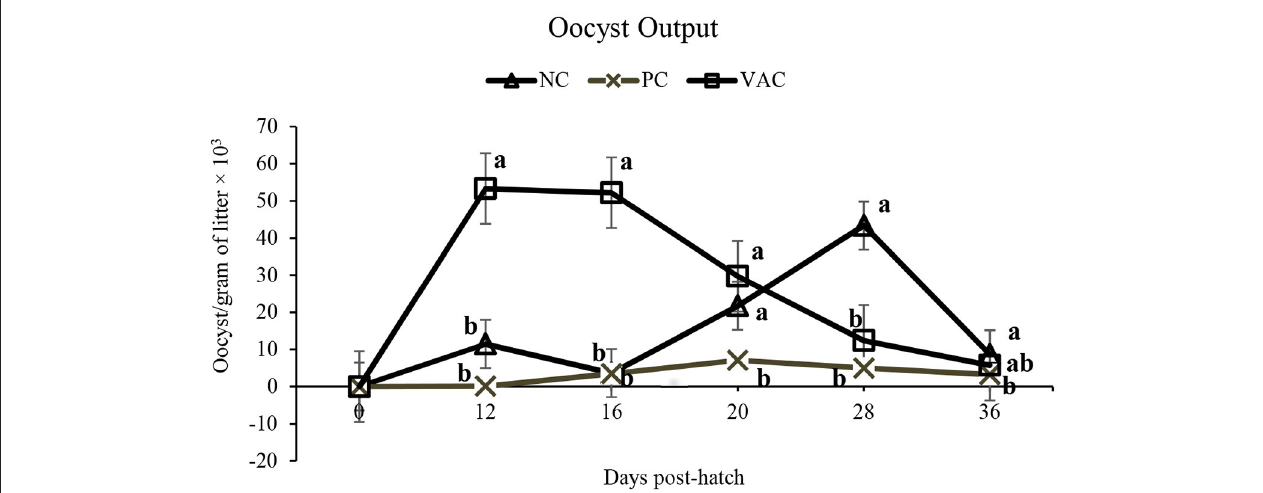
FIGURE 1 | The effects of coccidiosis vaccination on litter oocyst counts from 0 to 36 d post-hatch. Values are LSMeans of 10 replicate pens. NC, negative control; PC, positive control, birds were given an in-feed anticoccidial drug; VAC, vaccinated, birds were given a commercial dose of vaccine on 0 d. Within each time point, lines that do not share a common superscript are different ( P <